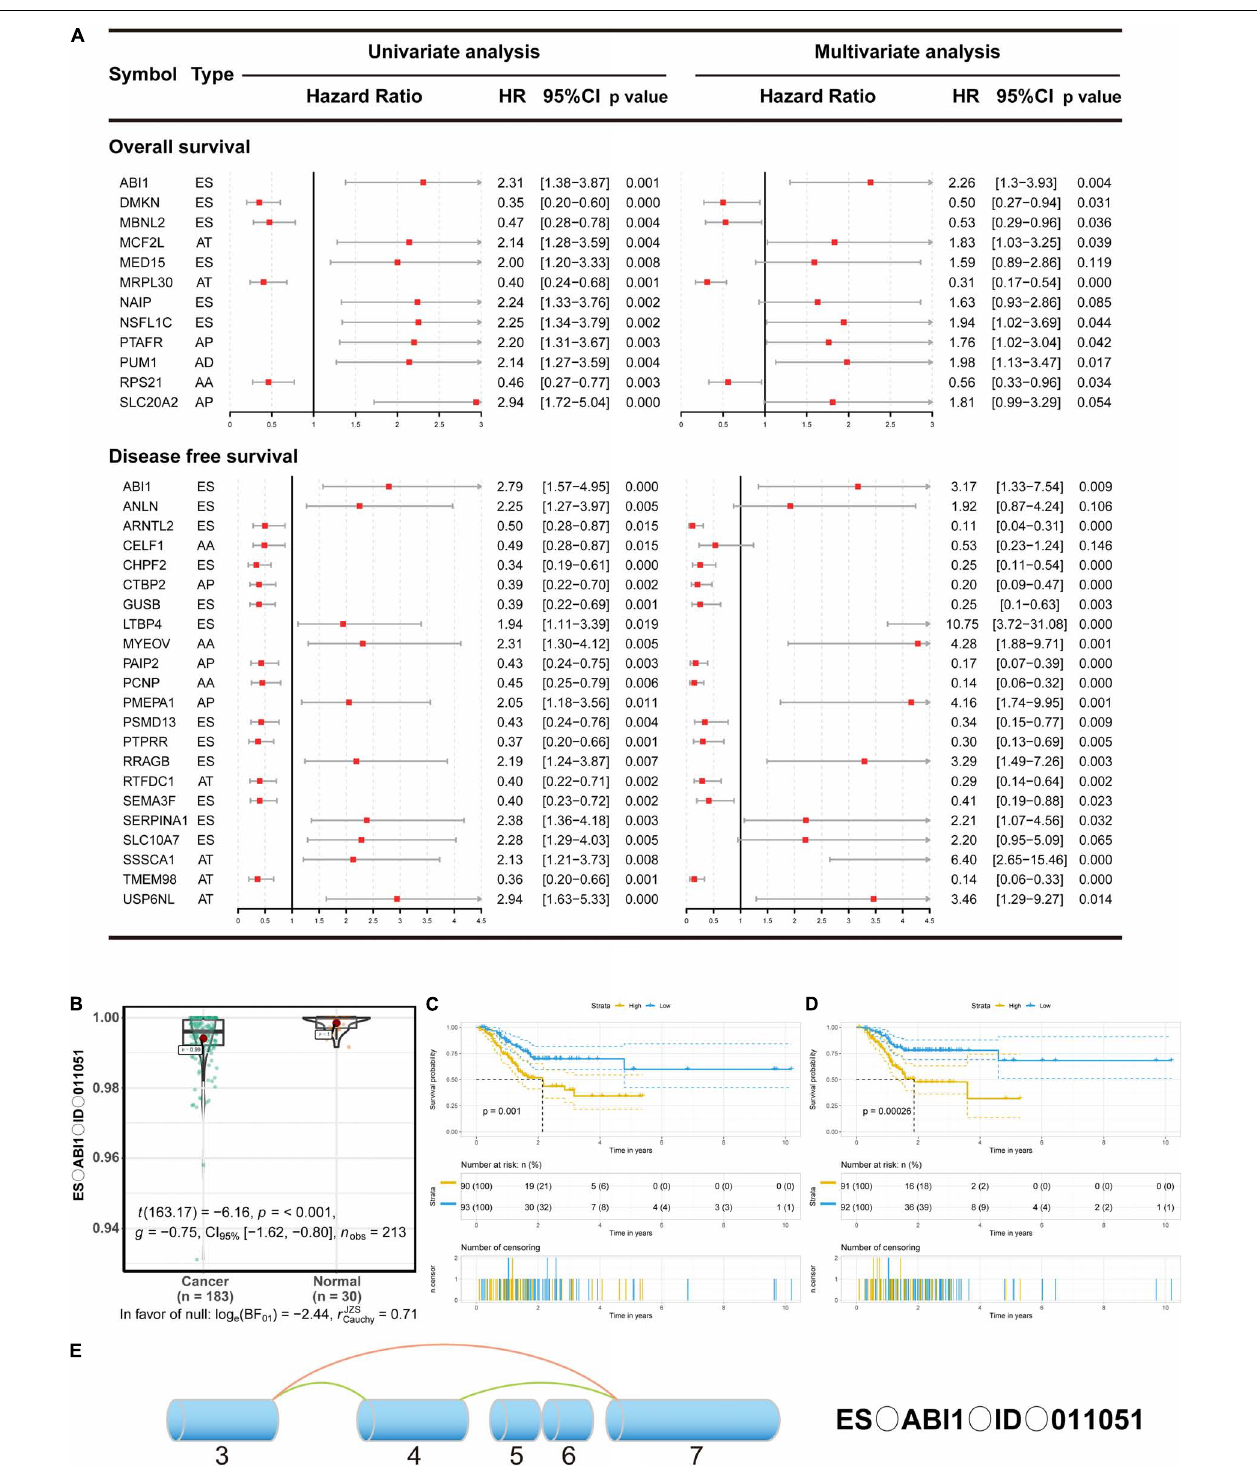
FIGURE 4 | The prognostic value of DEAS in GC. (A) DEAS that were simultaneously associated with OS and DFS. Univariate and multivariate analysis of DEAS on OS and DFS. Unadjusted HRs (boxes) and 95% confidence intervals (horizontal lines) limited to DEAS with P < 0.05. Box size is inversely proportional to the width of the confidence interval. (B) The different PSI values of the ES event in ABI1 in the normal tissues and GC tissues. (C,D) Prognostic signatures based on ES events in ABI1 in GC for both OS and DFS. Patients were divided into high- and low-risk groups according to prognostic signatures. The figure contains three parts: [1] survival differences estimated by Kaplan-Meier survival curve; [2] number of patients in different groups; [3] number censored at different times; (E) Splice graph of ES events in ABI1. Exons are drawn to scale, and the connecting arcs represent splice paths.